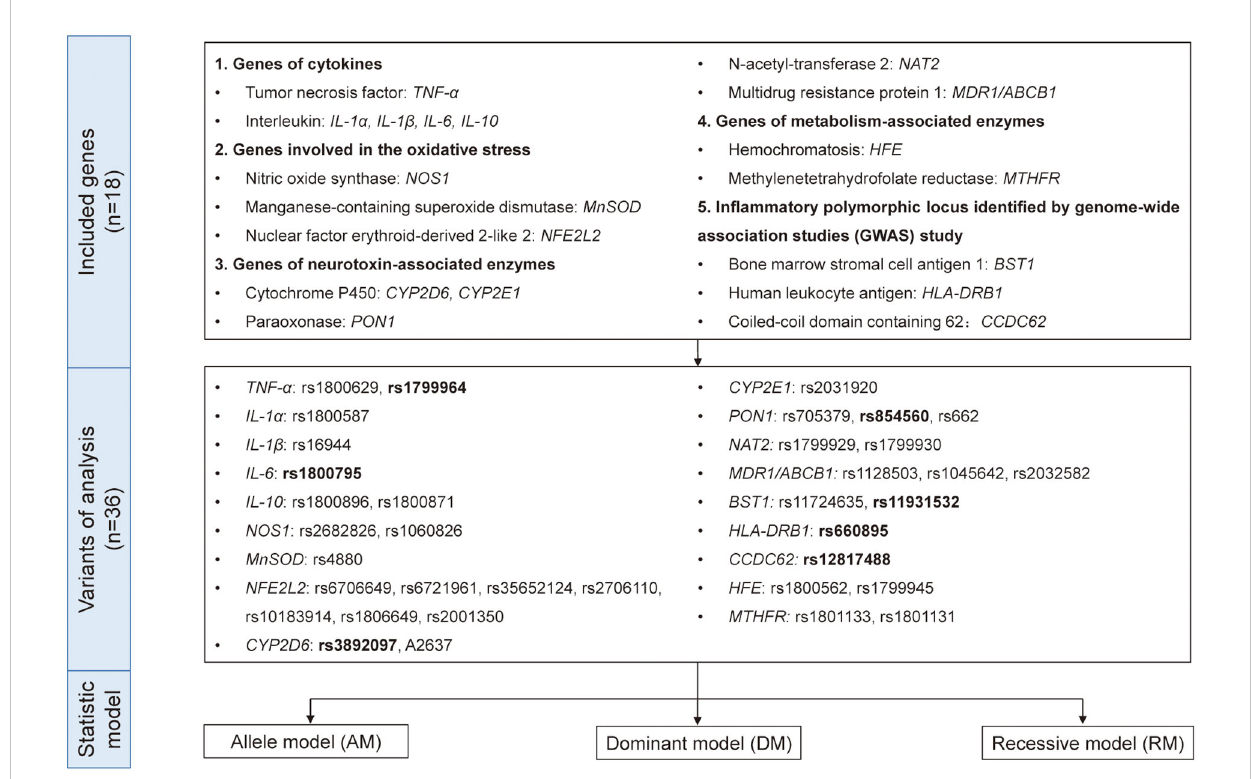
FIGURE 1 The genes, variants, and data analysis models included in the quantitative analysis. Eighteen genes with 36 variants from fi ve different functional types were included in this study. We used allele model (AM), dominant model (DM), and recessive model (RM) for quantitative analysis and the variants in bold indicated p<0.05 in either